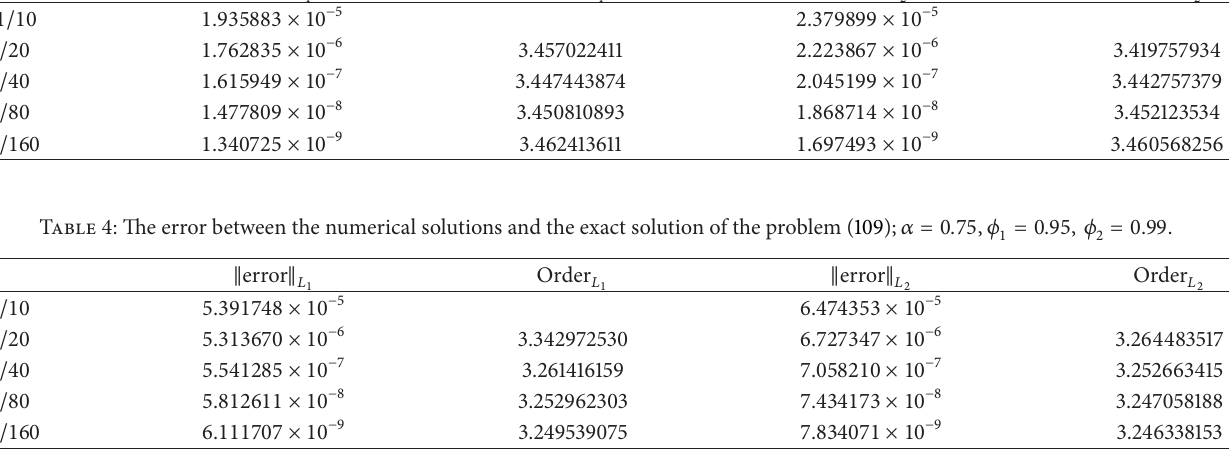
Table 3: The error between the numerical solutions and the exact solution of the problem (109); 𝛼 = 0.5 , 𝜙 1 = 0.88, 𝜙 2 = 0.98 . ℎ ‖ error ‖ 𝐿 1 Order 𝐿 1